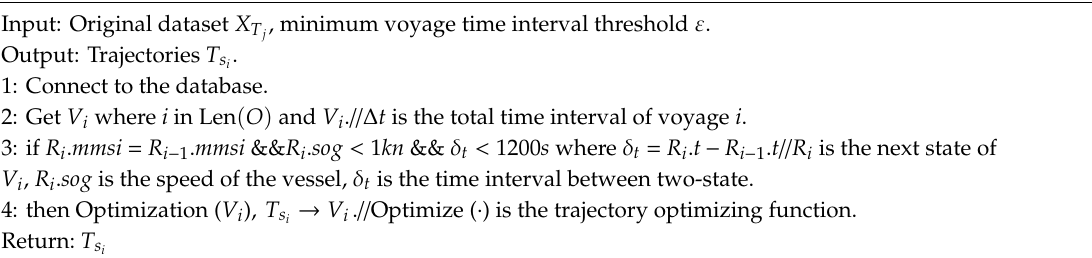
Algorithm 1 : Data preprocessing